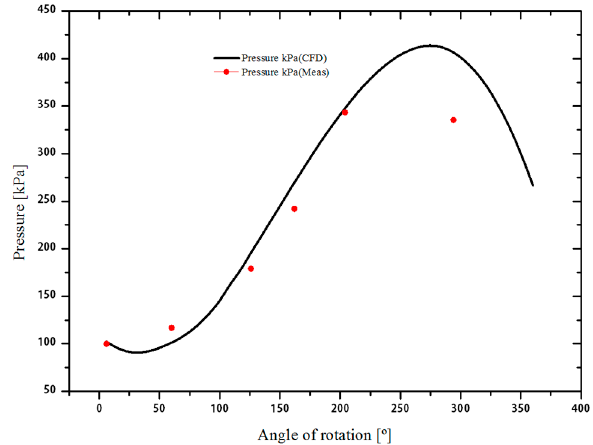
Figure 15. Comparison results of pressure distribution at the discharge port between CFD and measurement.